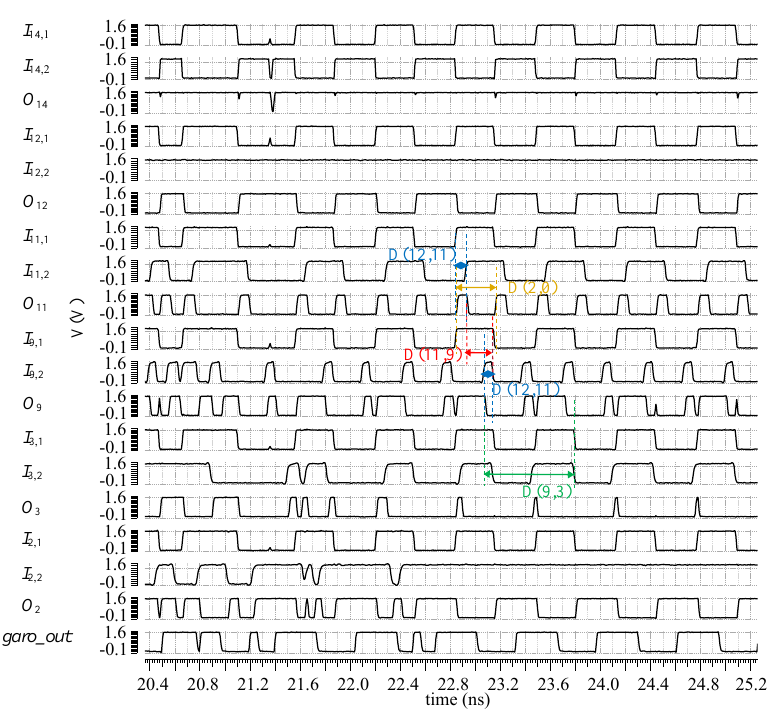
Figure 16: The simulated waveforms with feedback polynomial f ( x ) = x 15 + x 14 + x 12 + x 11 + x 9 + x 3 + x 2 +